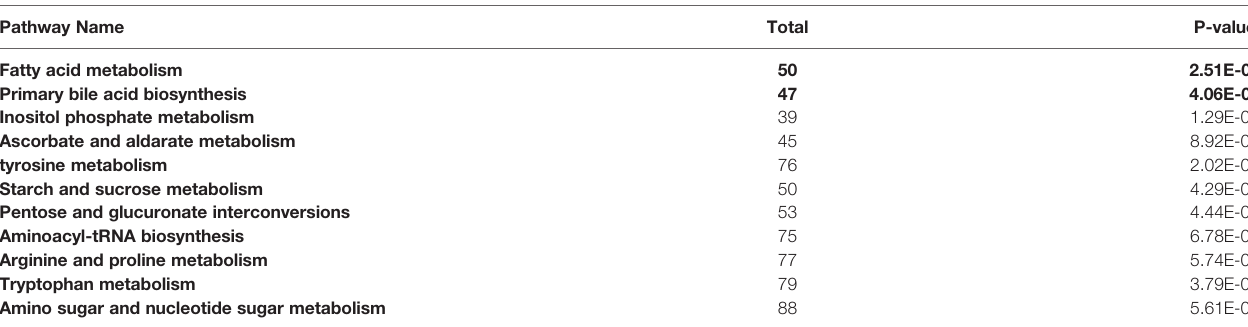
TABLE 3 | Pathway analysis of metabolite changes in ICP in the